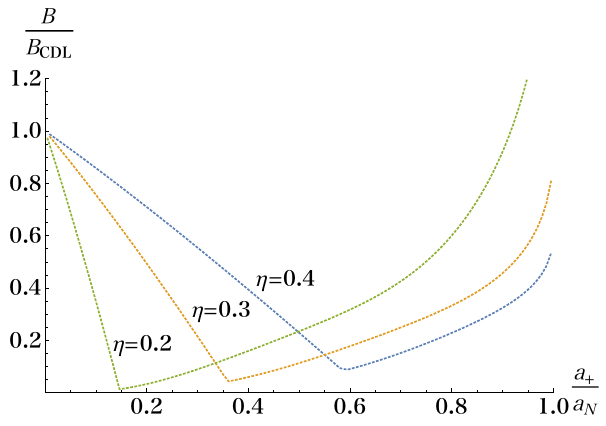
Figure 4 . The bounce action for the catalytic decay of AdS 5 to Minkowski